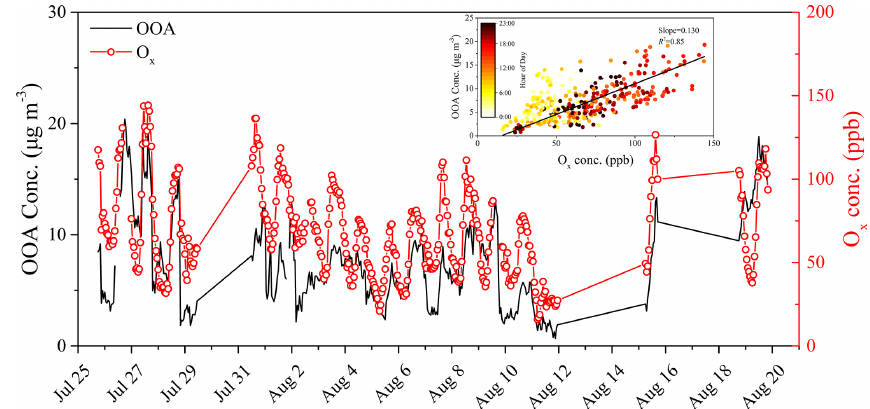
Figure 3. Time series of OOA ( = LO-OOA + IO-OOA + MO-OOA) and O x ( = O 3 + NO 2 ). The inset is a scatterplot of OOA vs. O x with linear fit and colored by the time of day. The regression slope is 0.130 ( R 2 = 0.85).